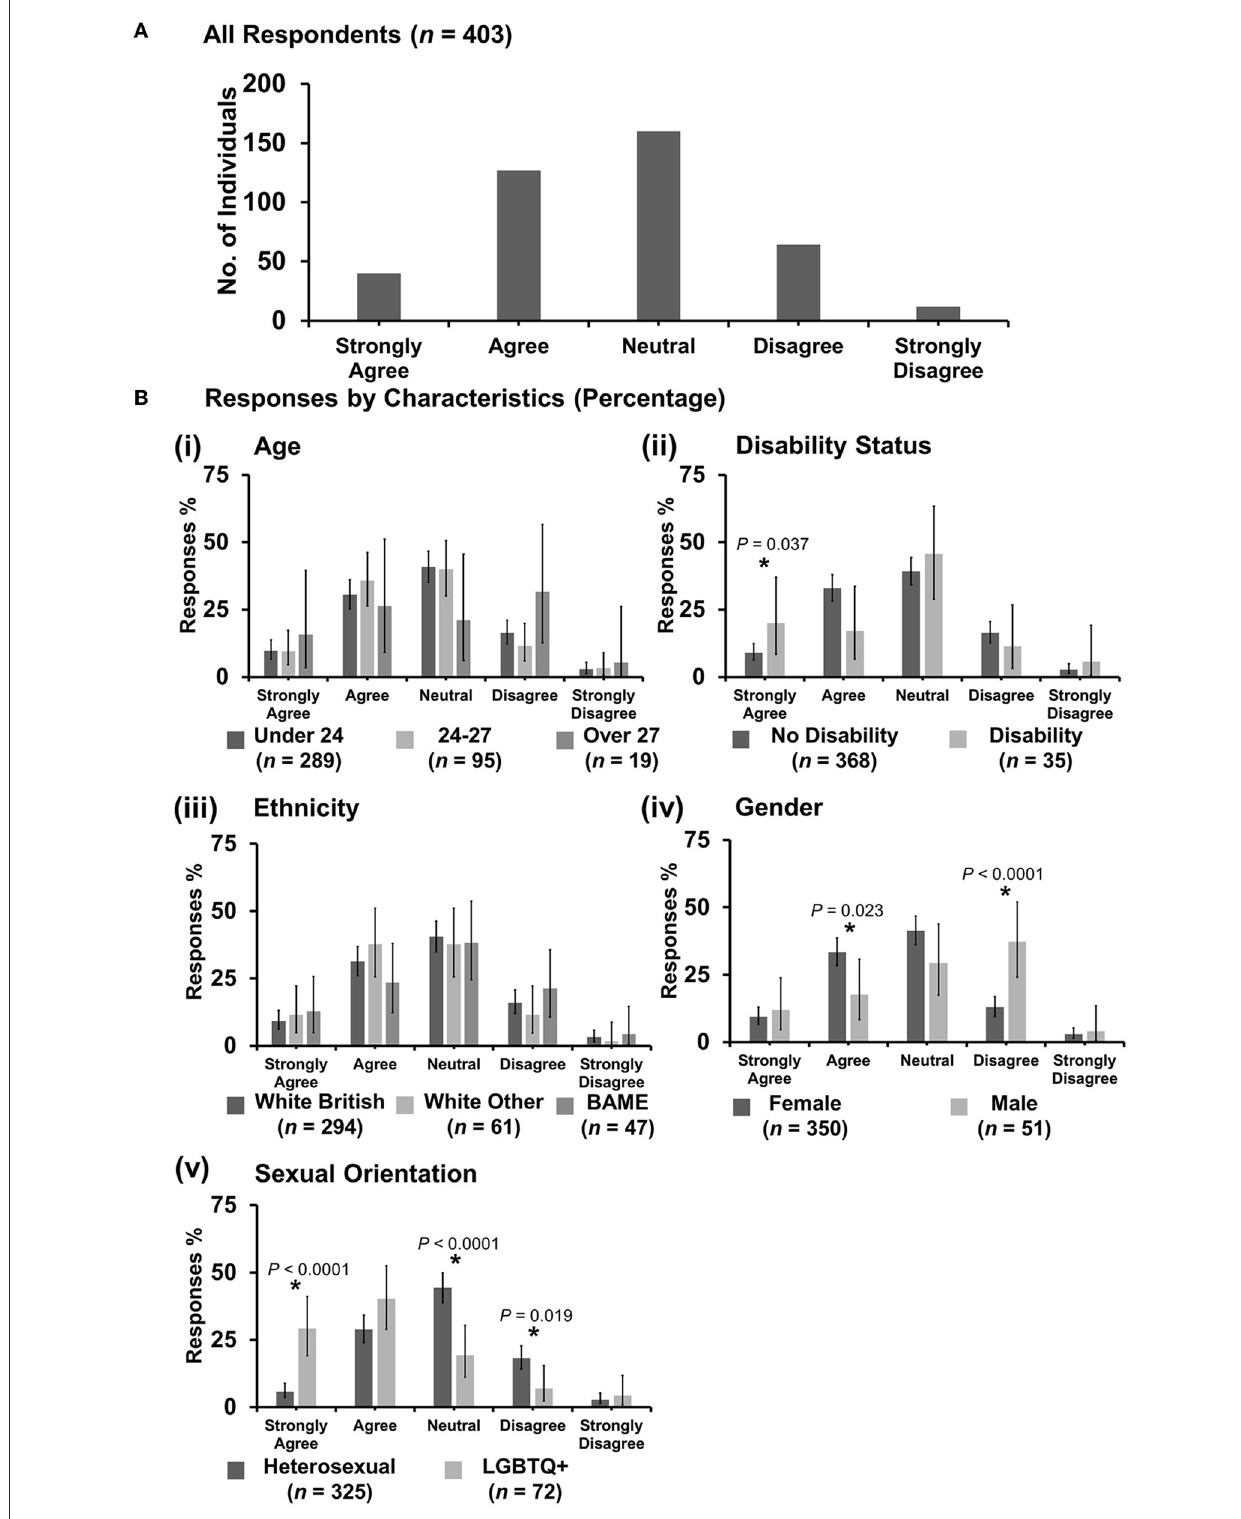
FIGURE12 Likert scale selections for the statement: known LGBTQ + status leads to an increased risk of discrimination for veterinary students. (A) Bar graph demonstrating the number of respondents selecting each Likert scale response. [ (B) i–v] Bar graphs demonstrating by percentage proportion the number of responses in each Likert category by the group under the demographic categories of age, disability status, ethnicity, gender, and sexual orientation. Error bars represent 95% confidence intervals calculated by the Binomial “Exact” method. Statistical significance was determined by Pearson’s chi-squared test of association between respondent’s group under category and Likert scale selection. * P <